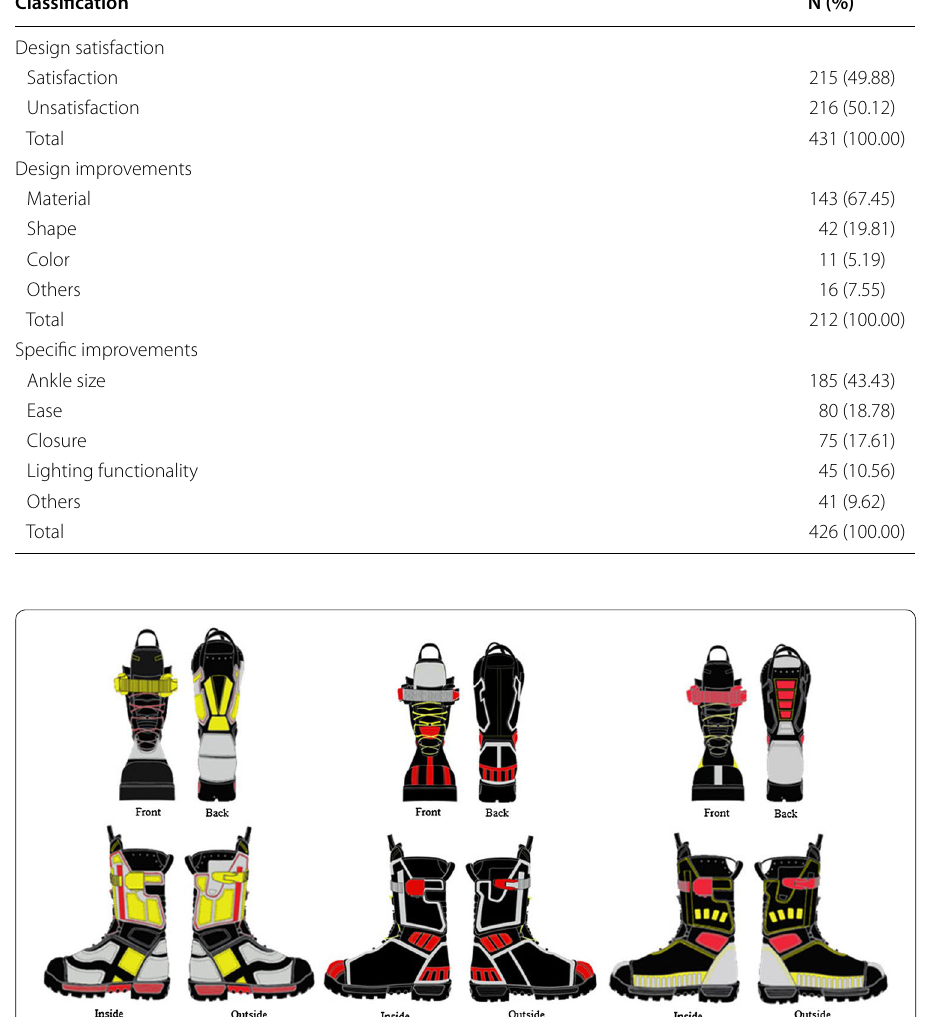
Table 4 Design evaluation of protective footwear for firefighters in Korea Classification